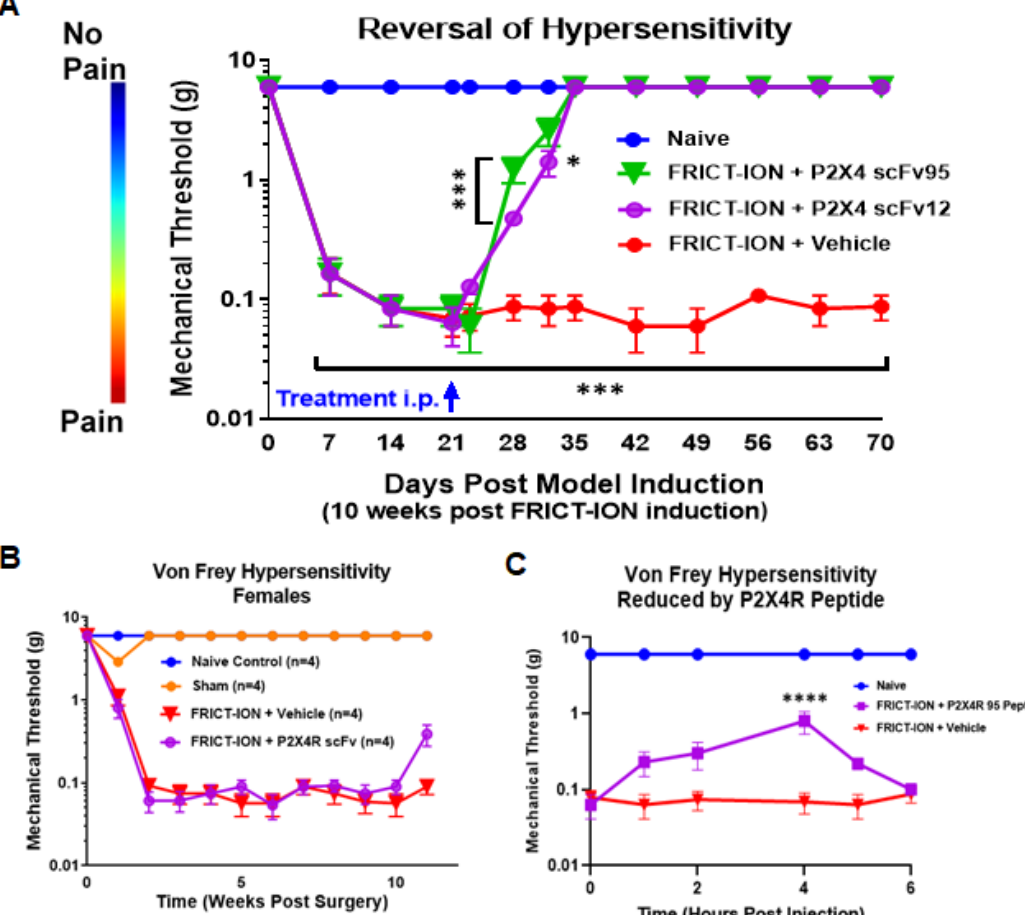
Figure 4. P2X4R scFv reverses mechanical hypersensitivity in male mice. ( A ). A single dose of two P2X4R scFvs (95 or 12) given 3 weeks after induction of FRICT-ION model permanently reverses mechanical hypersensitivity in male mice through to the end of the seven week study time course ( n = 6, two-way ANOVA (Dunnett’s multiple comparisons test)). ( B ). The scFv had no effect on responses of female mice with FRICT-ION-induced mechanical hypersensitivity ( n = 4). ( C ). Blocking peptide targeting the same P2X4R peptide fragment significantly reduced hypersensitivity, increasing the mechanical threshold 4 hours after treatment but the effect was short-lived. * p < 0.05, *** p < 0.001, and **** p <